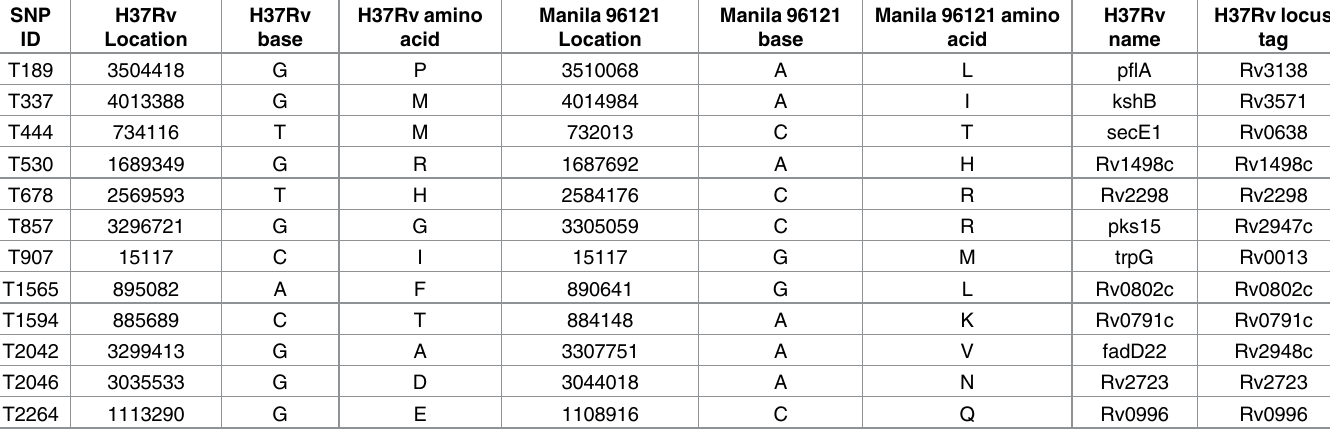
Table 2. List of Manila 96121 nonsynonymous SNPs in protein coding